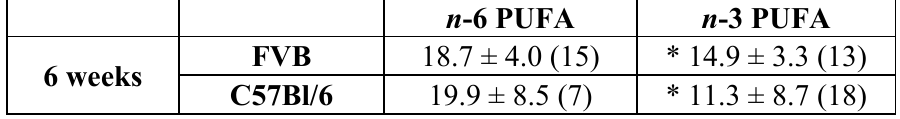
Table 1. Terminal end buds (TEB) Development in FVB and C57Bl/6 Mice.